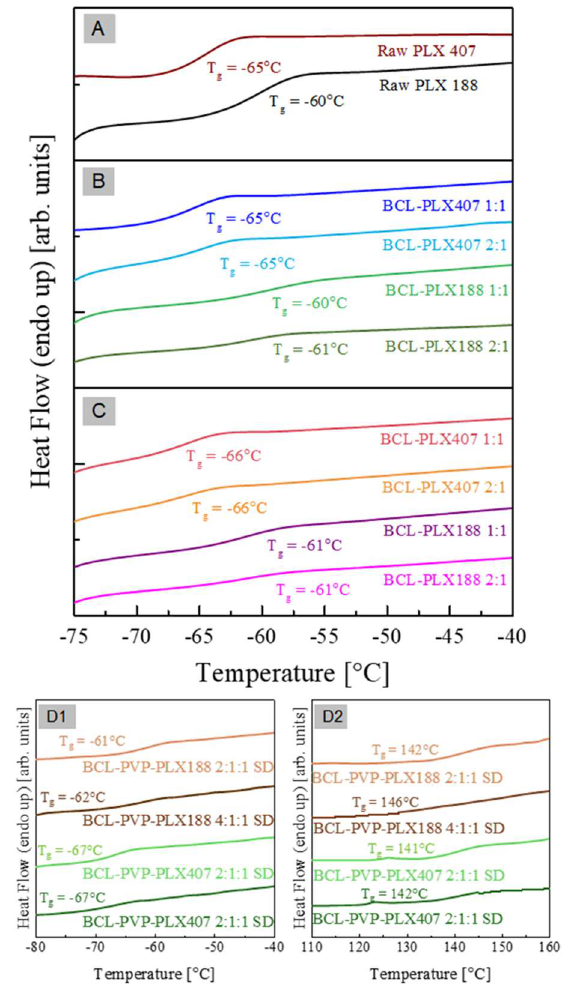
Figure 8. The zoomed fragment of DSC thermograms presented in the Figure 7 of raw bicalutamide and poloxamers ( A ), binary systems containing bicalutamide and either PLX188 or PLX407 obtained using evaporation method ( B ) and spray drying ( C ), and ternary, spray-dried, systems containing BCL, poloxamer, and PVP ( D1 and D2 ) .